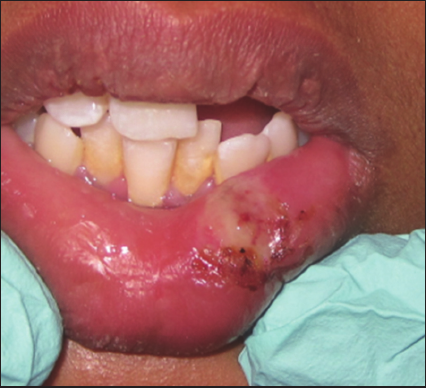
Figure 8: Photograph showing postoperative view: Day 1.